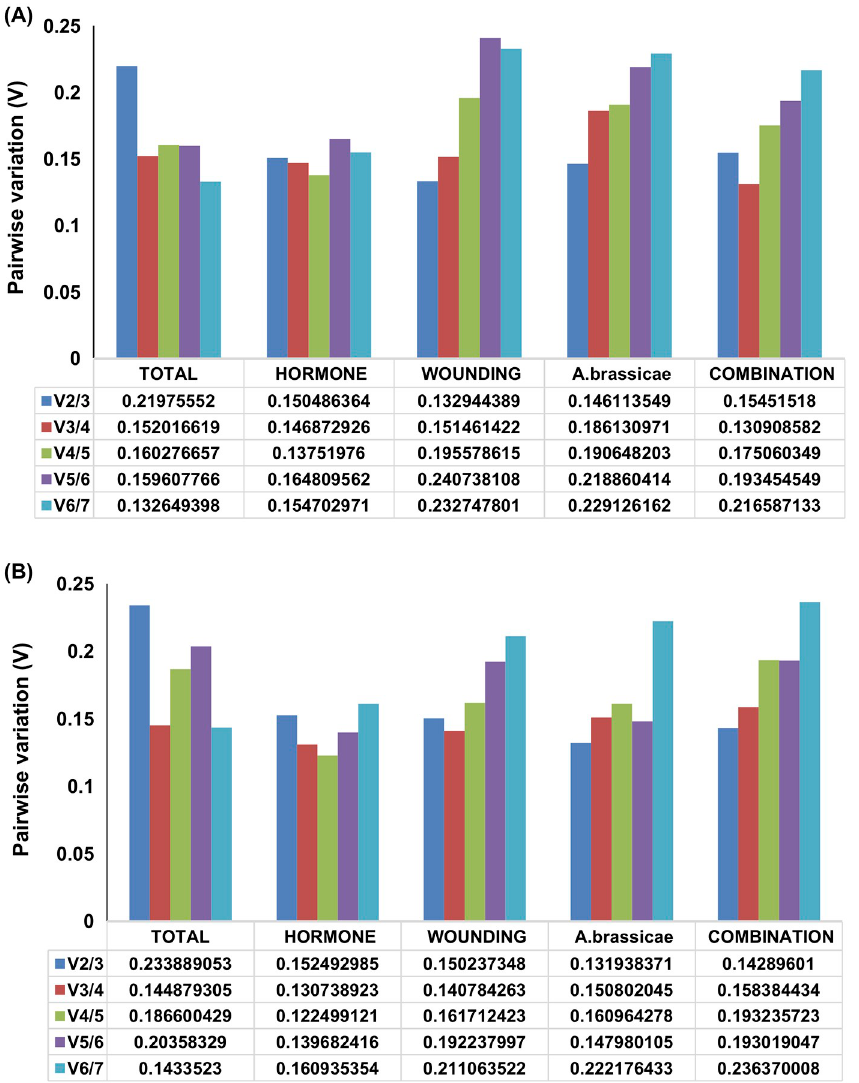
Fig 4. Determination of optimum number of reference genes for an accurate normalization. (A) B . juncea (B) C . sativa . Pairwise variation (V n / V n+1 ) analysis of 7 reference gene in each experimental